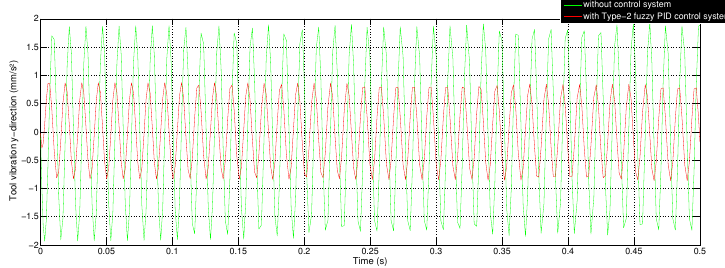
Figure 13. Tool vibration along y − direction using type-2 Fuzzy PID control.